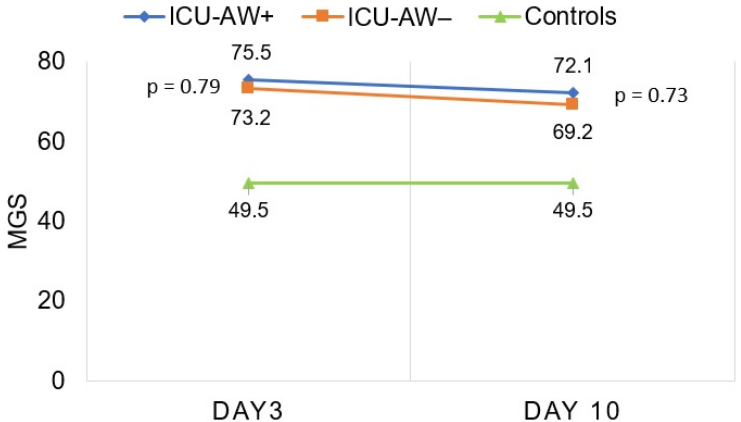
Figure 2. Longitudinal assessment of the MGS in ICU-AW+ patients, ICU-AW − patients and healthy controls on days 3 and 10. ICU-AW: intensive care unit-acquired weakness. ICU-AW+: patients with intensive care unit-acquired weakness. ICU-AW − : patients without intensive care unit-acquired weakness. ICU: intensive care unit. MGS: global mean greyscale score.